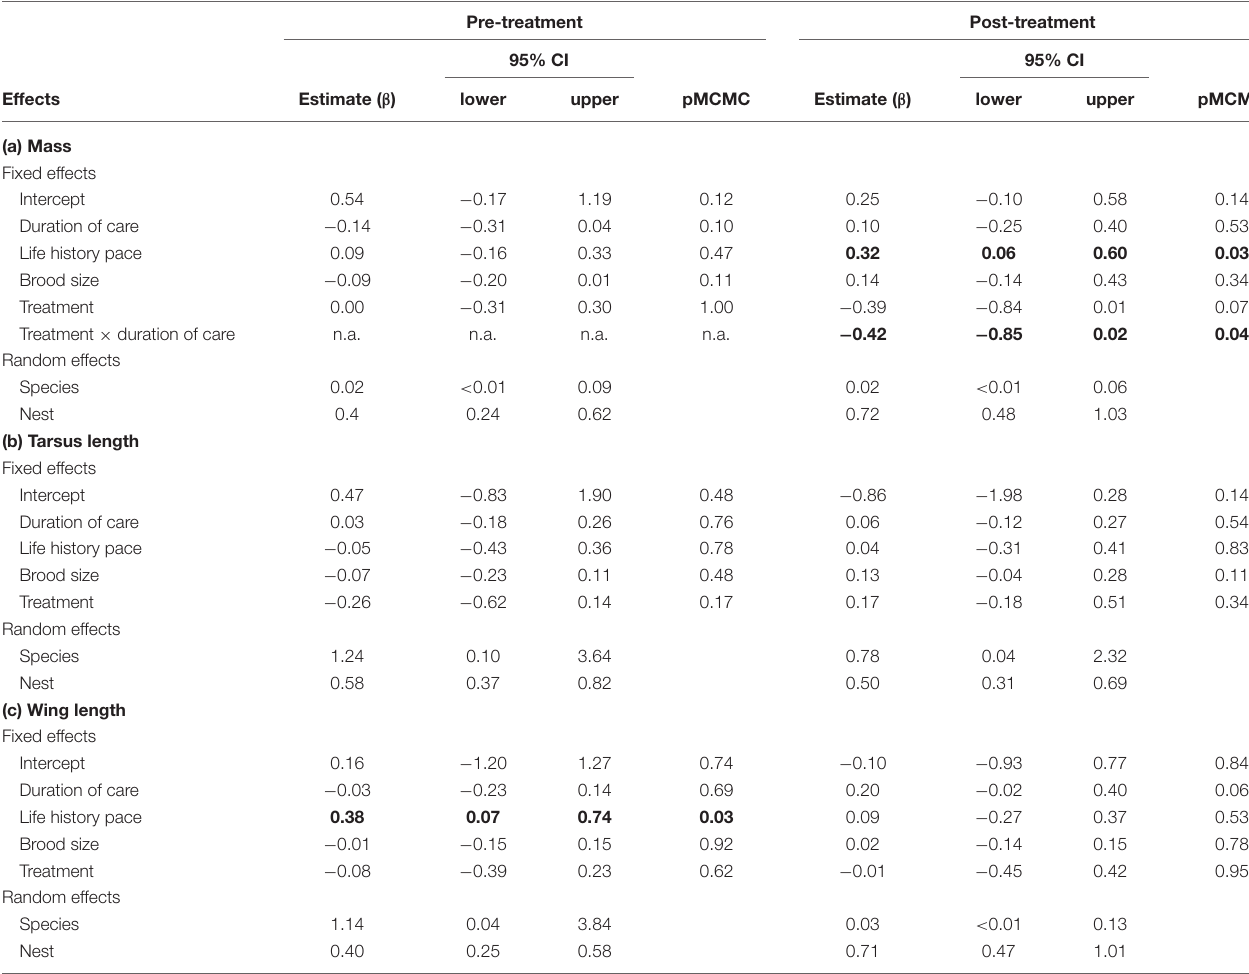
TABLE 4 | Mixed model results of effects on nestling (a) mass, (b) tarsus length, and (c) wing length before and after the handicapping (or control catching) of one parent. Pre-treatment